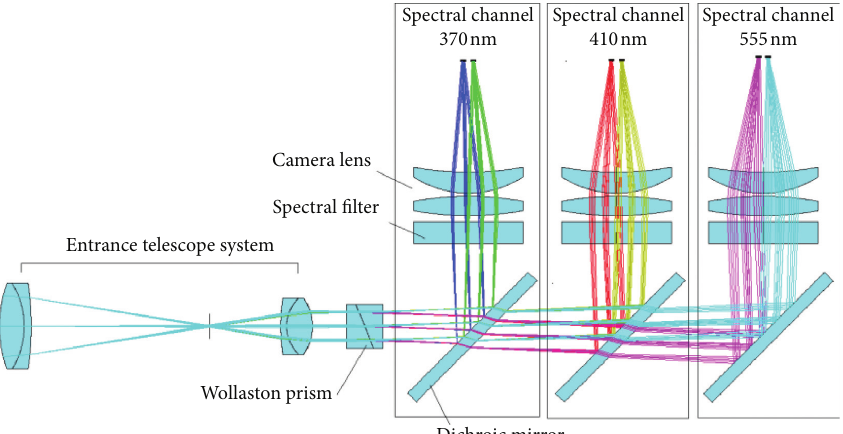
Figure 2: The optical layout of the VIS channel of the ScanPol